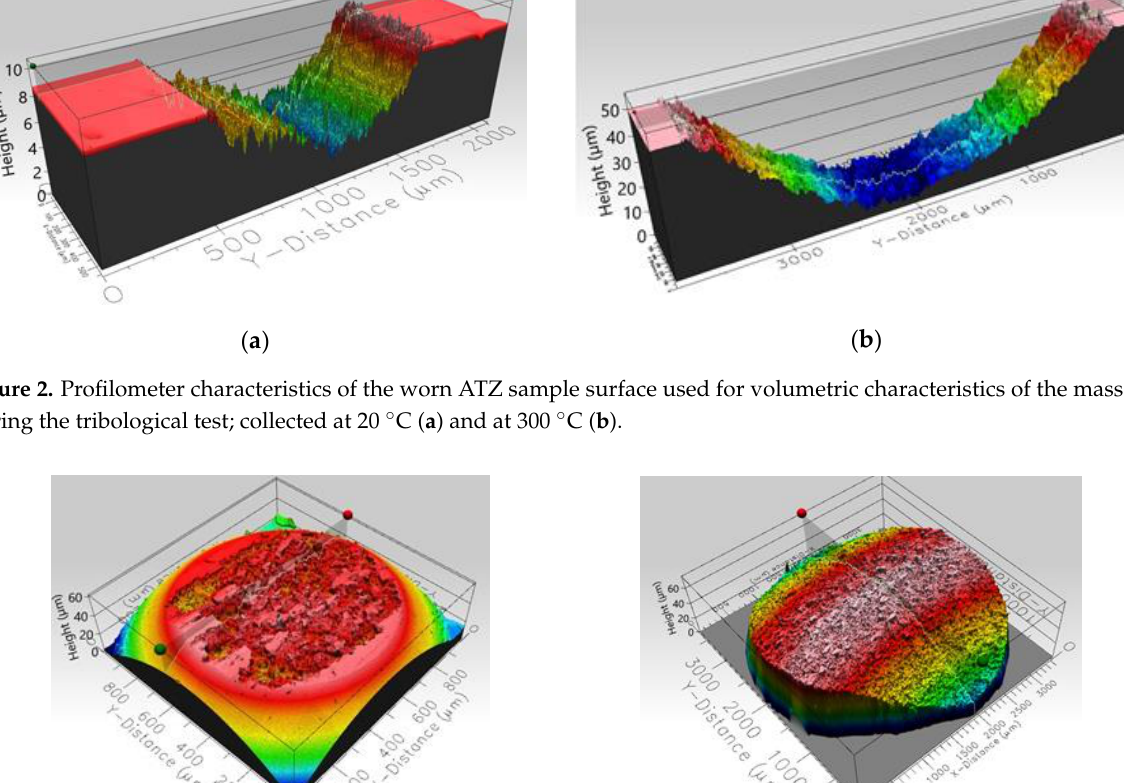
Figure 3. Profilometer characteristics of the worn alumina ball (counterpart) surface used for volumetric characteristics of the mass loss during the tribological test; collected at 20 °C ( a ) and at 300 °C ( b ).